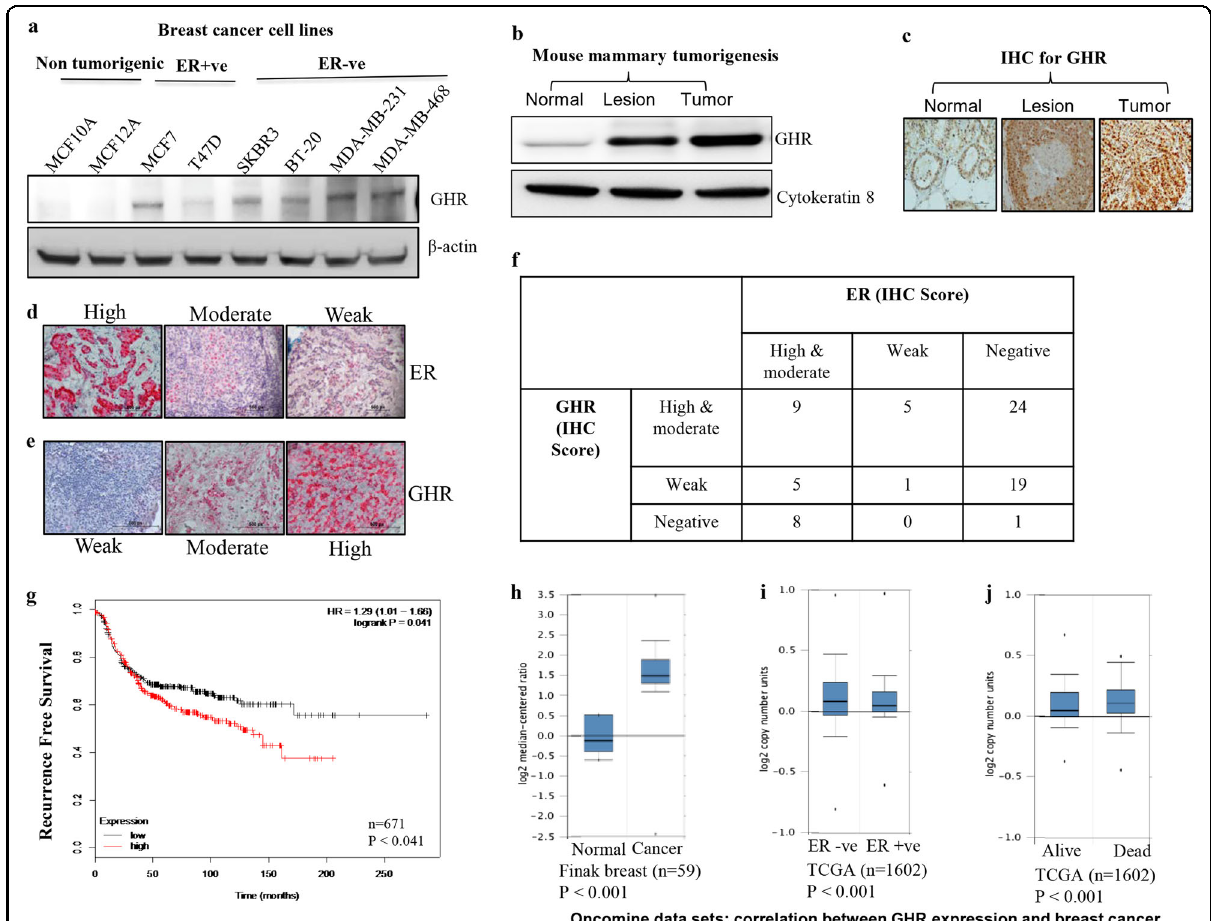
Fig. 1 GHR is overexpressed in breast cancers. a GHR expression in a panel of breast cancer cell lines. ER negative breast cancer cell lines express higher levels of GHR. b Western blot analysis of GHR expression. GHR expression is lower in the normal mammary tissue and shows increased expression in mammary lesion and tumor tissues ( n = 3). c GHR expression in normal mammary gland, mammary lesion, and mammary tumors using IHC. d and e Estrogen receptor alpha (ER α ) and GHR expression in human primary breast cancers using IHC. Representative images of weak ( + ), moderate (2 + ) and high (3 + and above) ER α and GHR staining. f IHC scoring of GHR and ER in 72 human breast cancer tissues. g Survival probability of ER − ve breast cancers with low or high GHR expression; calculated using KM plotter ( n = 671). h – j Oncomine data sets showing the correlation between GHR expression and breast cancer aggressiveness and prognosis. h GHR expression was higher in tumor tissues than in normal tissues (Finak breast data set ( n = 59)). i The TCGA data set showed that GHR expression was high in ER − ve tumors compared with the less aggressive ER + ve tumors ( n = 1602). j GHR expression was low in patients alive 1 year after diagnosis. The fi lters for the analysis are p < 0.001 and a fold change